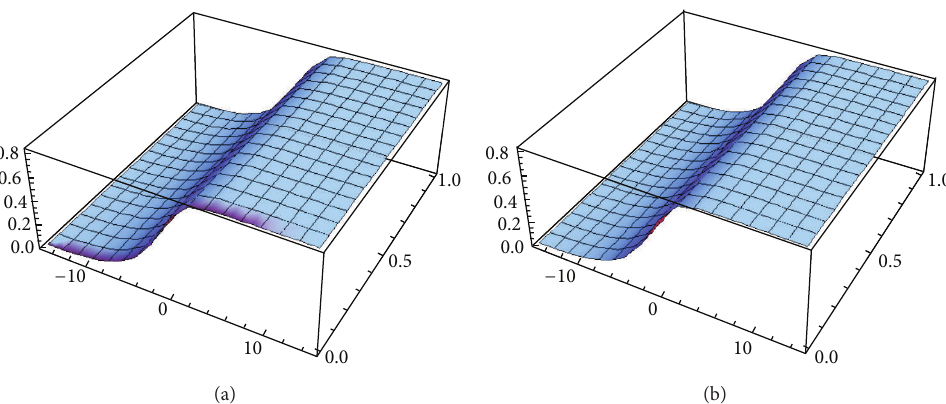
Figure 5: Graph of the solution (29) corresponding to the values 𝛼 = 0.05 , 𝛼 = 0.85 , respectively, when 𝑘 = 1 , 𝑝 = 1 , 𝛽 = 4 , −15 < 𝑥 < 15 , and 0 < 𝑡 < 1 .